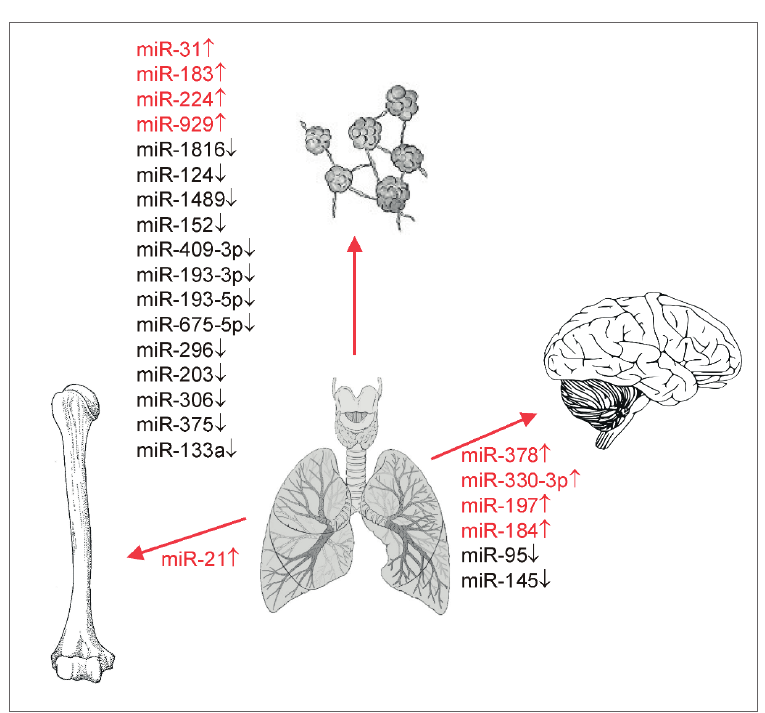
Fig. 1. altered microrNa expression in Nsclc leading to metastasis spread to brain, lymph nodes and